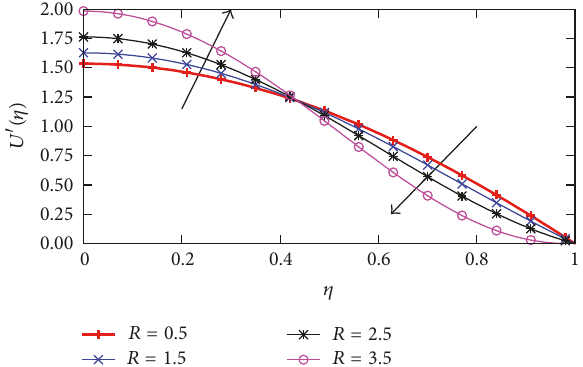
Figure 7: Effect of positive Reynolds number 𝑅 on the longitudinal